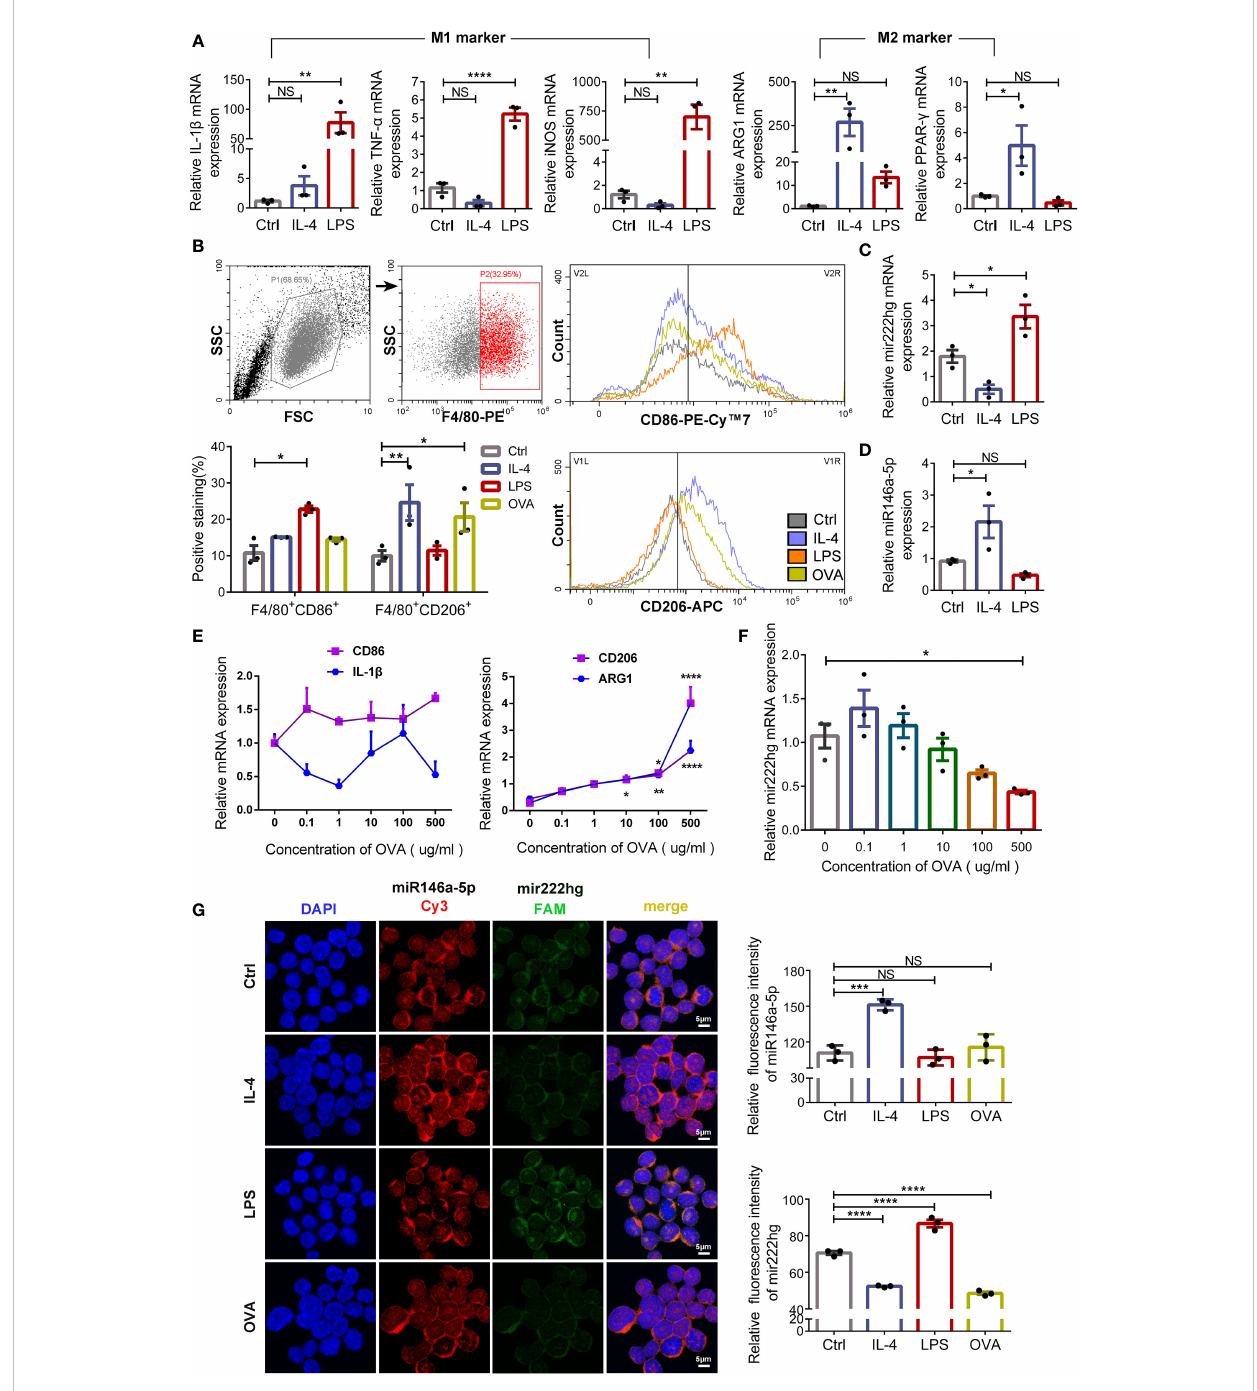
FIGURE 4 Mir222hg is signi fi cantly upregulated in LPS-stimulated M1 macrophage and downregulated in IL-4/ovalbumin-stimulated M2 macrophage (A) The qRT-qPCR showing IL-1 b , TNF- a , iNOS, ARG1, and PPAR- g relative mRNA expression in LPS-induced M1 and IL-4-induced M2 macrophages. (B) Representative fl ow cytometry plots and statistical analysis showing the surface expression of CD86 and CD206 in LPS-induced M1 and IL-4/OVA- induced M2 macrophages. (C, D) The relative transcript-level expression of mir222hg (C) and miR146a-5p (D) in LPS-induced M1 and IL-4-induced M2 macrophages were analyzed by qRT-PCR. (E, F) The qRT-qPCR showing CD86, IL-1 b , CD206, ARG1, and mir222hg relative mRNA expression in RAW264.7 cells treated with different concentrations of OVA (0.1-500 m g/ml) for 48 h. b -actin was used as an internal control. (G) Representative images (left) and quanti fi cation analysis (right) of RNA-FISH assay showing subcellular localization and expression of mir222hg and miR146a-5p in RAW264.7 cells treated with LPS, IL-4 and OVA, respectively (miR146a-5p-Cy3-red; mir222hg-FAM-green; nucleus-DAPI-blue). Scale bars, 5 m m. Each point represents data from one individual sample. Data are shown as the mean ± SEMs (n= at least 3 samples per group). Data are merged from three independent experiments. Statistical signi fi cance was calculated by two-way ANOVA followed by Sidak ’ s multiple comparisons test. * p< 0.05, ** p< 0.01, *** p< 0.001, **** p< 0.0001, NS no signi fi